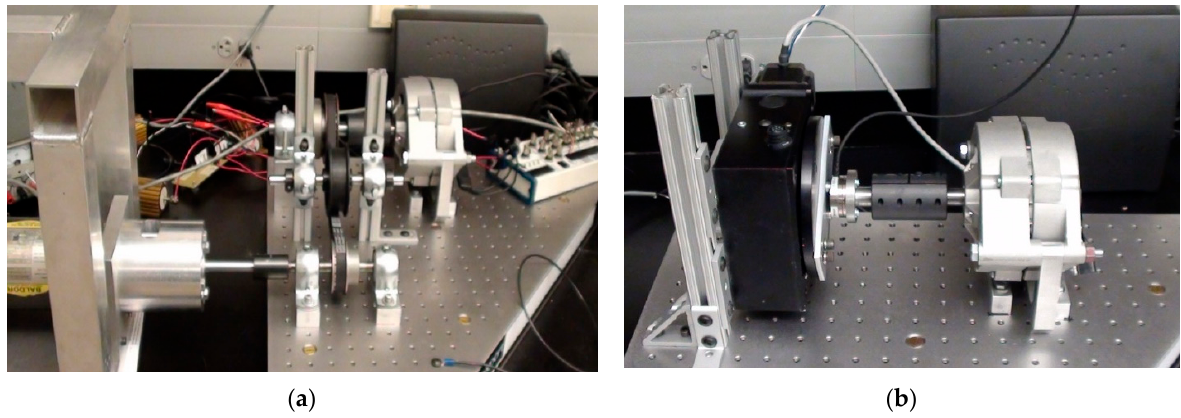
Figure 7. Experimental set-up ( a ) for dynamic measurements and ( b ) to measure the angular dependent parameters. The angular velocity was measured using a quadrature optical encoder connected to the generator rotor. The encoder output was converted to a voltage signal via a US-Digital ETACH2 analog tachometer. A National Instruments PXI DAQ system was used both data acquisition, data capture and control of the AMC driver. Using this set-up, three types of experiments were performed.